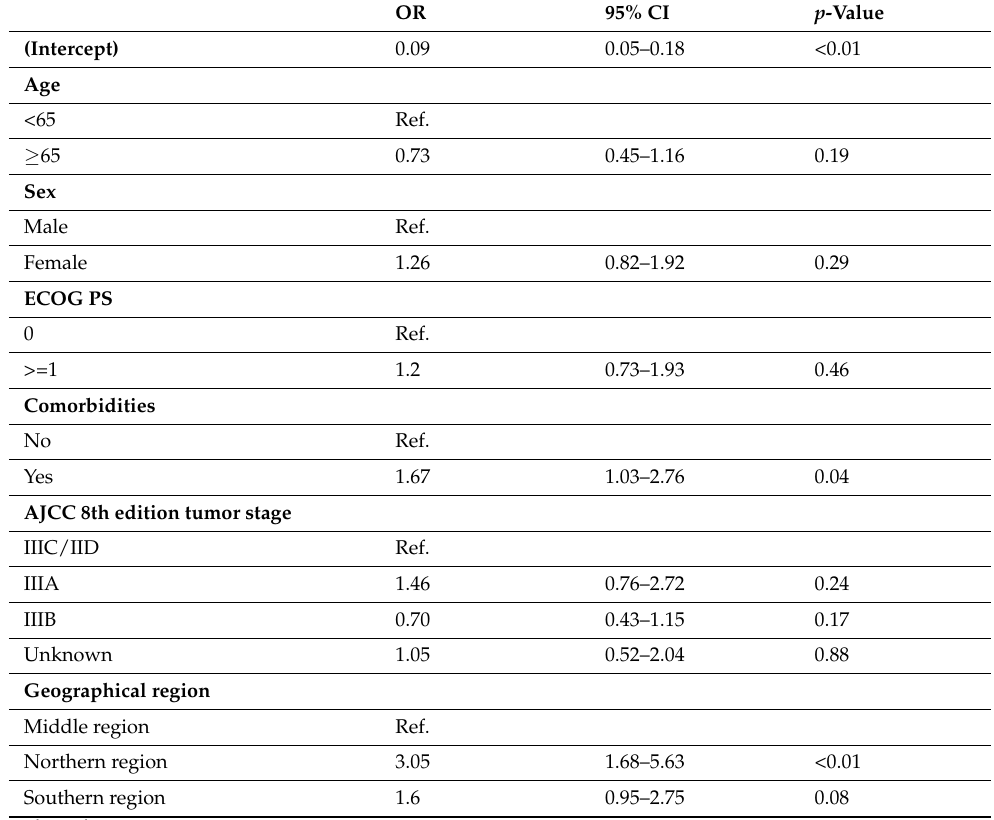
Table 2. Multivariable logistic regression for receiving BRAF/MEK inhibitors in study population.